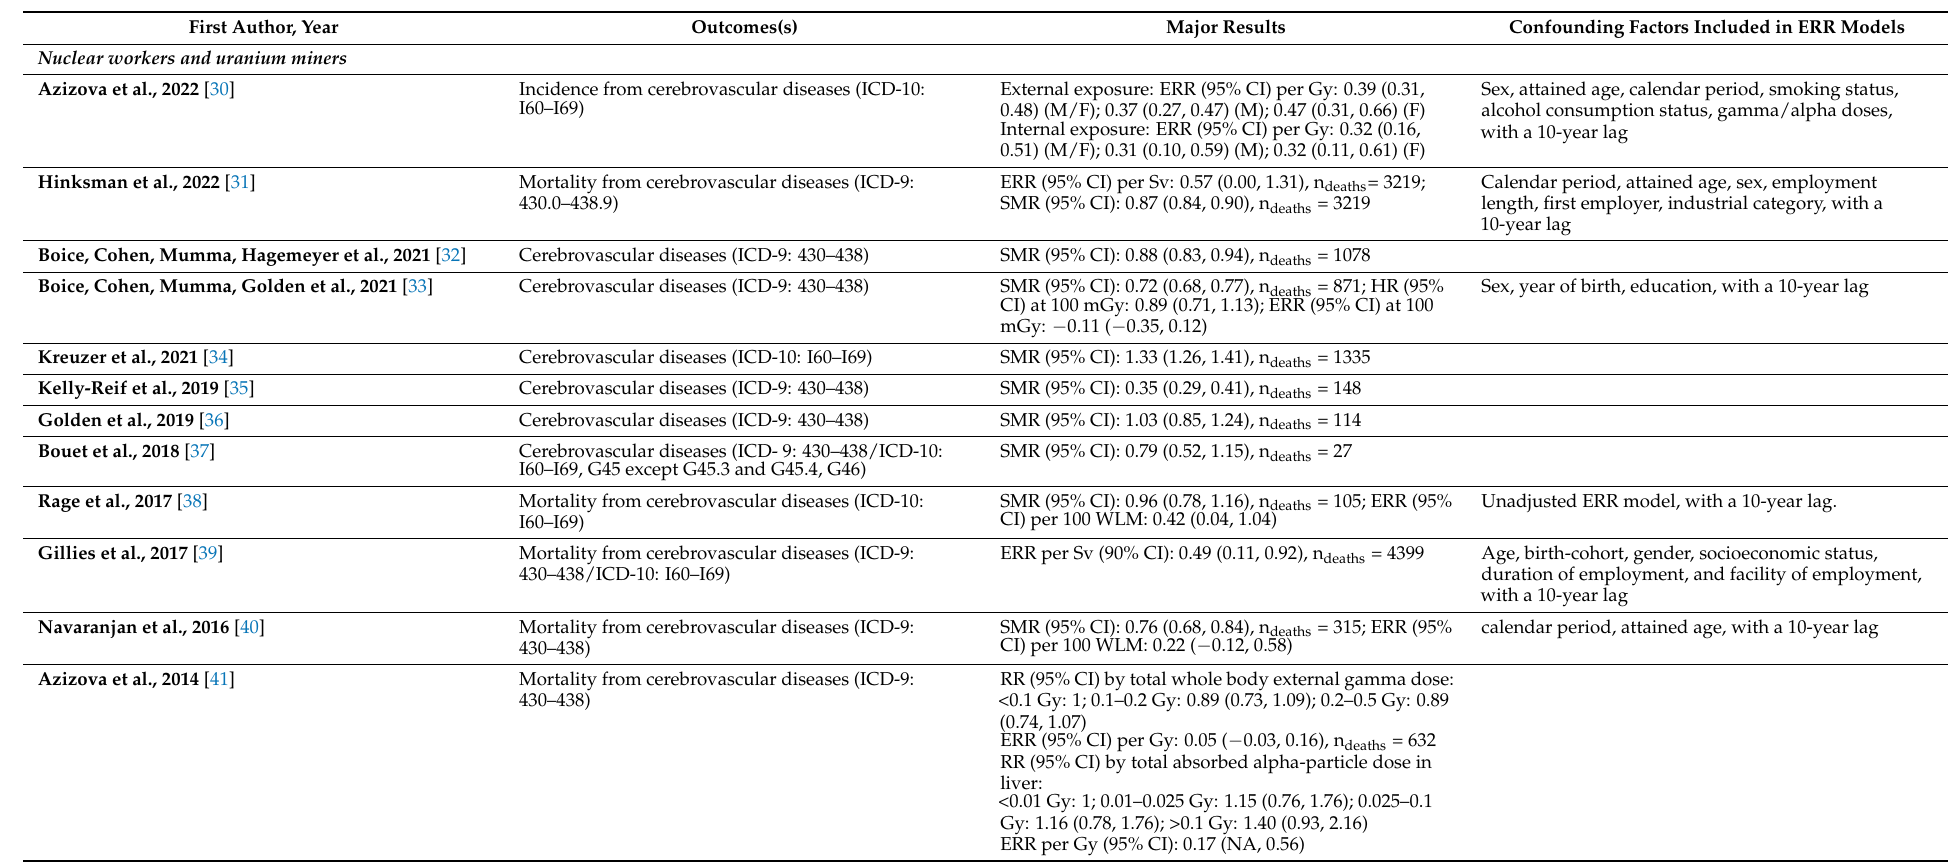
Table 3. Key findings of the included studies on cerebrovascular